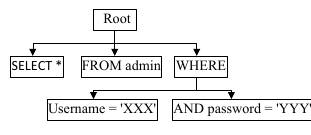
Figure 2. Standard AST of Example 1